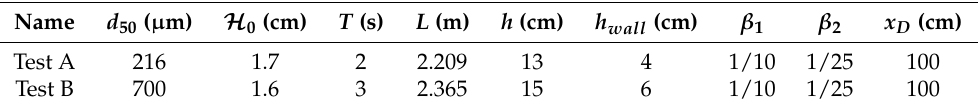
Table 1. Main parameters for the numerical